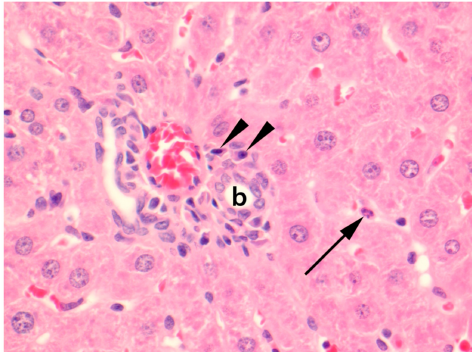
Figure 3. Photomicrograph of liver parenchyma of a natural Seoul virus (SEOV) infection in a feeder rat. A polymorphonuclear leukocyte (arrow) is present within a hepatic sinusoid, and centrally, a portal area with a bile duct ( b ) and blood vessels contains a mild lymphoplasmacytic aggregate of which plasma cells (arrowheads) are evident. Stained with haematoxylin & eosin (HE). Original magnification 400 ×